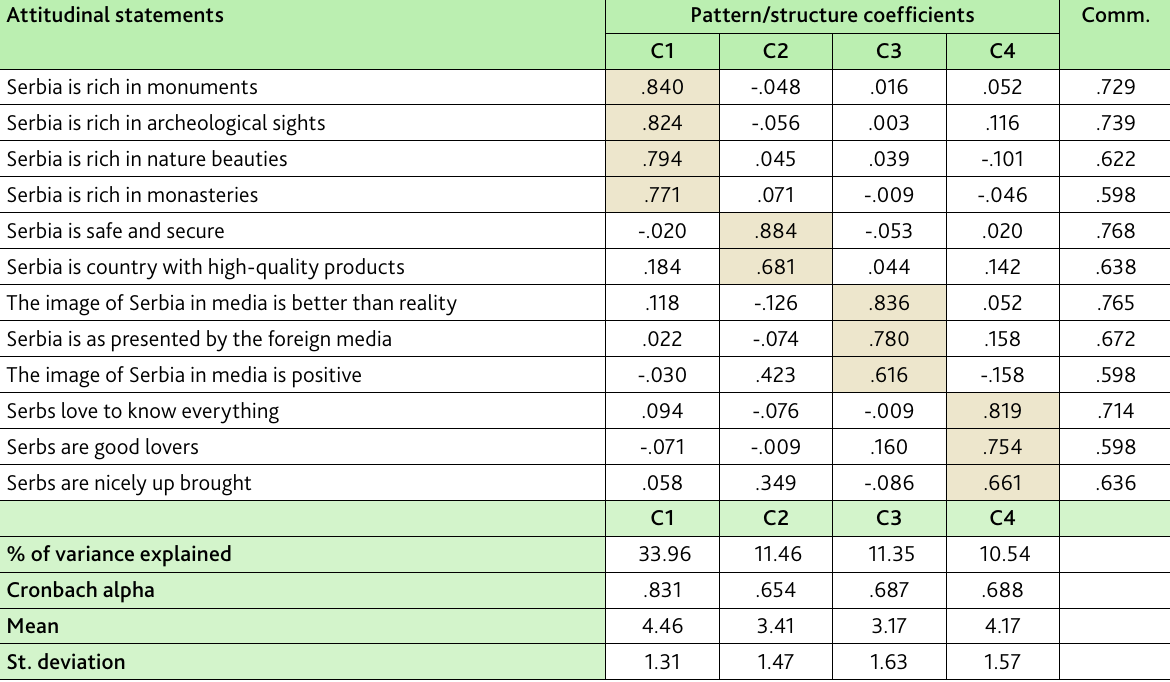
Table 4. Serbia brand identity Austrian perception – rotated component matrix for PCA with Oblimin rotation for 4 factor